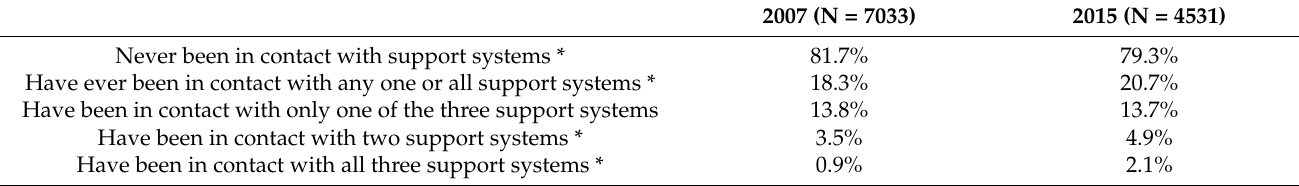
Table 2. Total access to support systems among youth in Norway: 2007 and